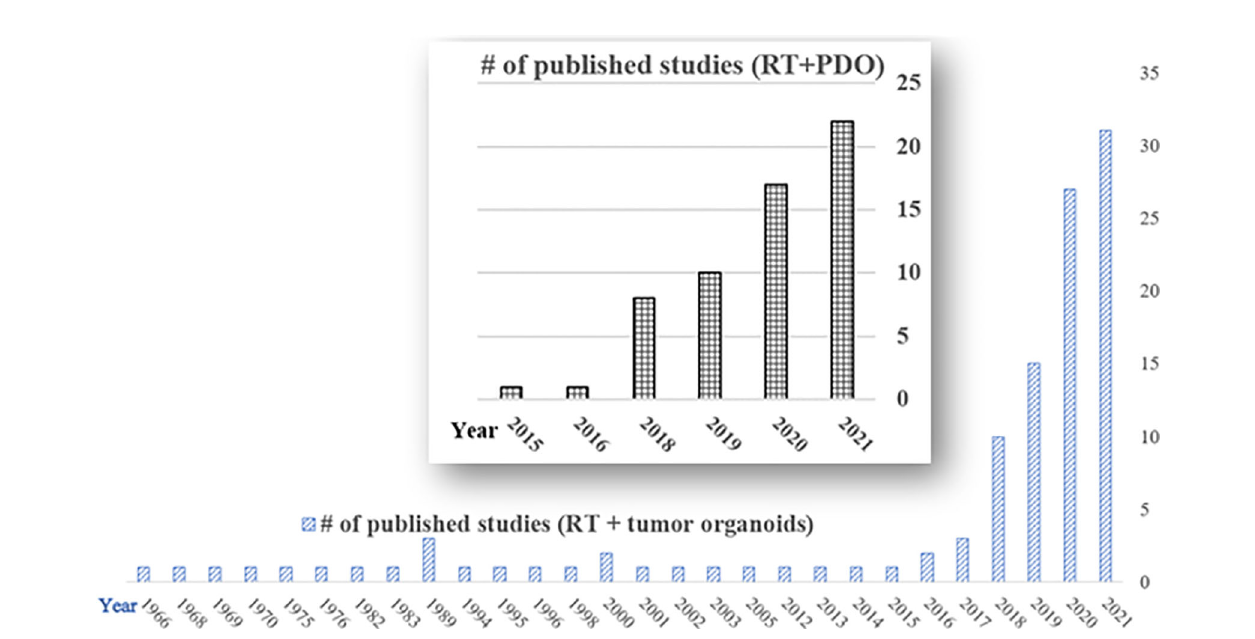
FIGURE 1 | Publications of radiotherapy and tumor organoids on PubMed (till Dec 31, 2020). Total number of published studies of radiotherapy and tumor organoids (RT + tumor organoids) = 113; total number of published studies of radiotherapy and patient-derived organoids (RT+PDO) = 59. Notice there is a surge in the RT and PDO research area in the last four years